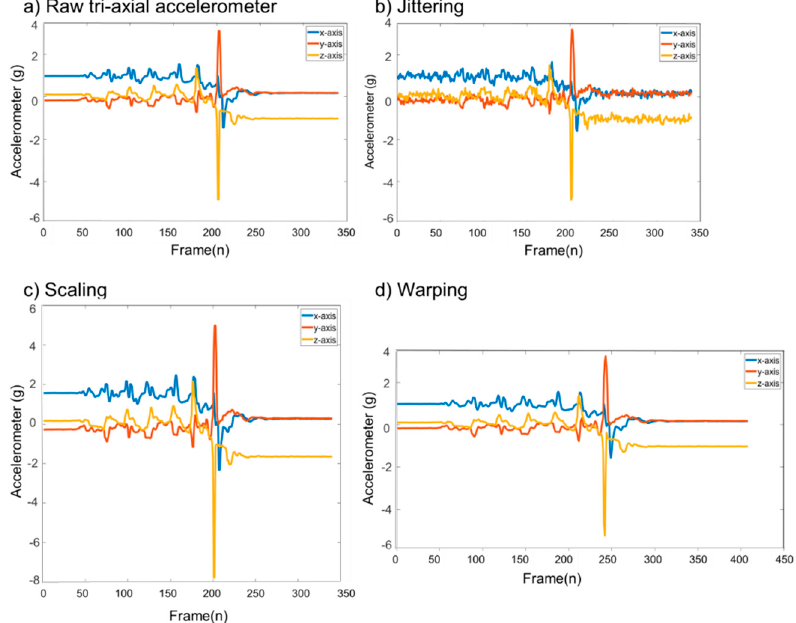
Figure 5. Three di ff erent data augmentation techniques applied to raw tri-axis accelerometer data ( a ): jittering data augmentation technique; ( b ): scaling data augmentation technique; ( c ): time-warping data augmentation technique.